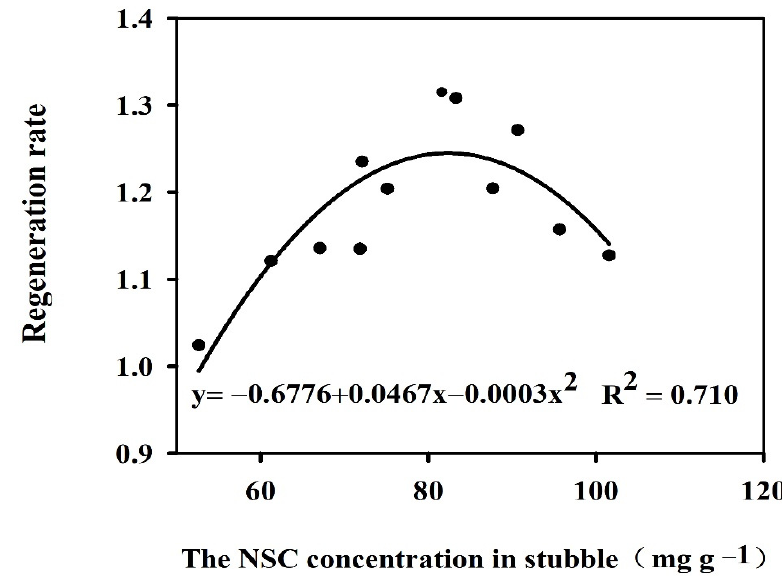
Figure 8. Relationships between stubble NSC concentration and regeneration rate.